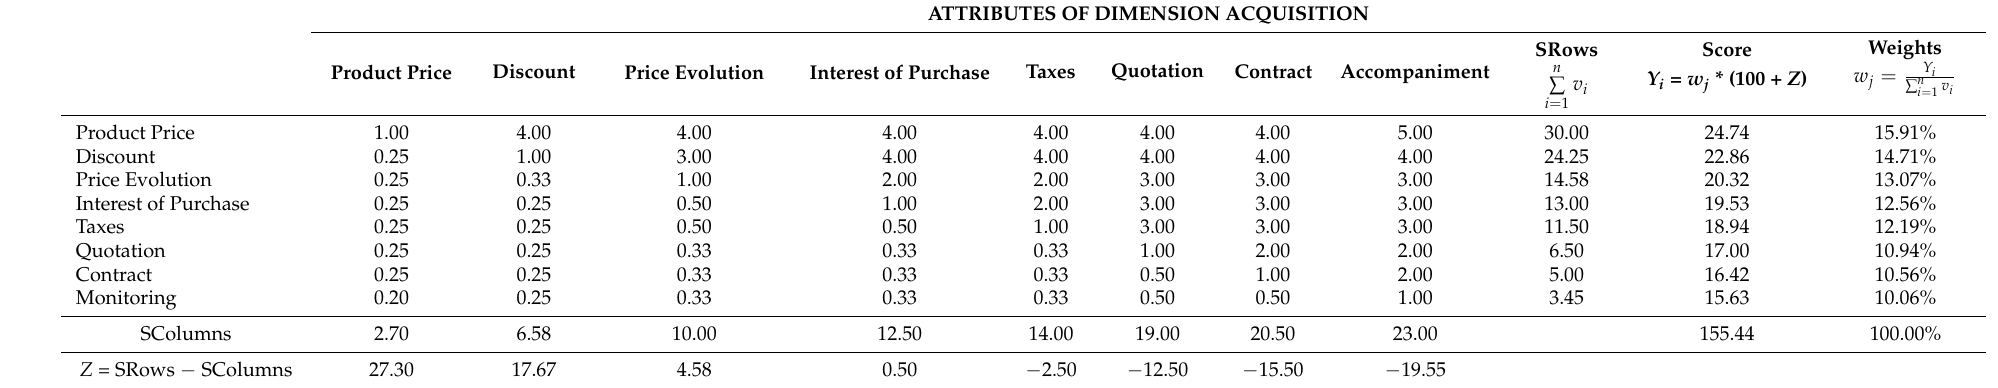
Table 8. Global Criteria Weight Evaluation (scale 1 to 5).